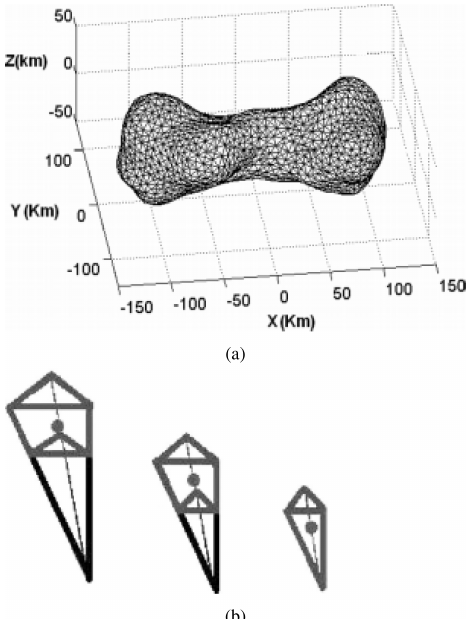
Figure 2. Modelling the gravity field of the asteroid 216 a.k.a. Kleopatra by point mass mascons according to Chanut et al. (2015). (a) Polyhedron model of the asteroid; (b) geometrically sub- division of one tetrahedron by parallel planes with the mascon lo- cations as large dots. Panel (b) was converted to grey-scale for this